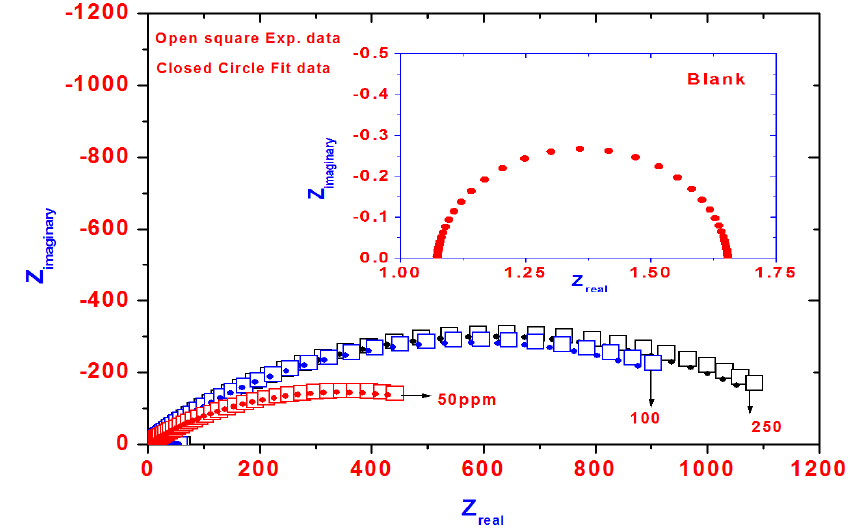
Figure 7. Nyquist diagram for steel in 1 M HCl solution containing different PAMPS-Na- co-St/magnetite concentrations showing experimental and fit